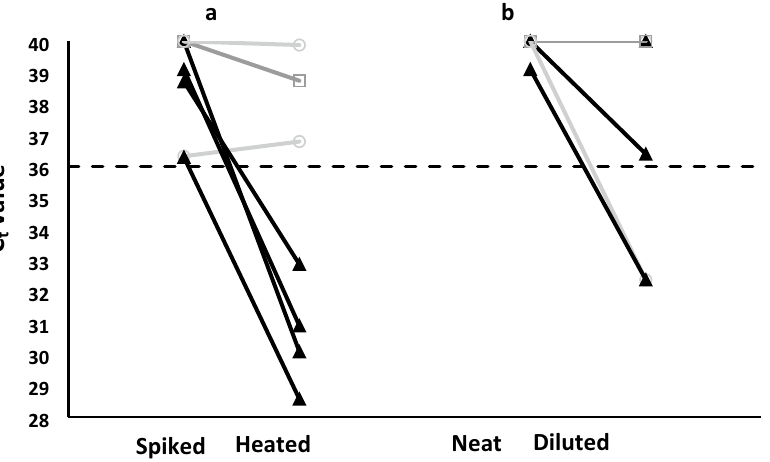
Figure 2. Effect of heat treatment or dilution of spiked saliva samples prior to testing. ( a ) Saliva samples from NPS negative or healthy volunteers that produced a false negative result after spiking with 10 6 genome copies/ mL heat-inactivated SARS-CoV-2 (Spiked) compared with the same saliva samples heated prior to spiking (Heated). ( b ) Spiked saliva samples that produced a false negative result (Neat) tested after dilution (Diluted). Solid black triangles represent samples that became detectable (C t < 36) after settling; dark grey open squares represent samples that showed improved C t values but remained above the cut-off C t value (C t > 36, black dashed line); light grey open circles represent samples that were either detectable in both groups or did not show an appreciable change in C t value (In panel B only, the light grey open circle represents 3 identical, undetectable samples.) A